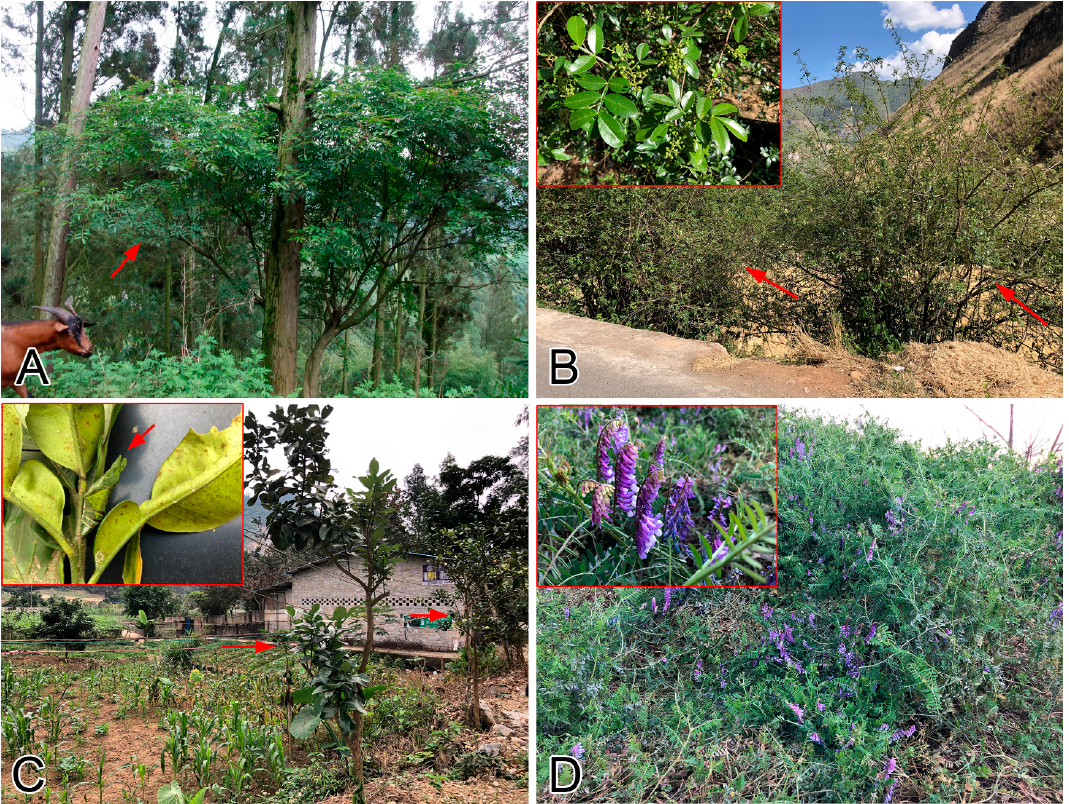
Figure 1. Examples of butterfly attracting plants in Chinese agroecosystems, cited from Zhang, Wang, Yu, Xing, Xu, Duan, Zhu, Zhang, Li and Hu [115]. ( A ): A Zanthoxylum bush (red arrow); ( B ): Zanthoxylum bushes as fence (red arrows), with fruiting branch in the red box; ( C ): Citrus maxima (pomelo) along the edge of field (red arrows), with a pupa of Papilio memnon attached to a branch in the red box (red arrow); ( D ): Vicia sp. during the seasonal rotation, with close up of flowers in the red